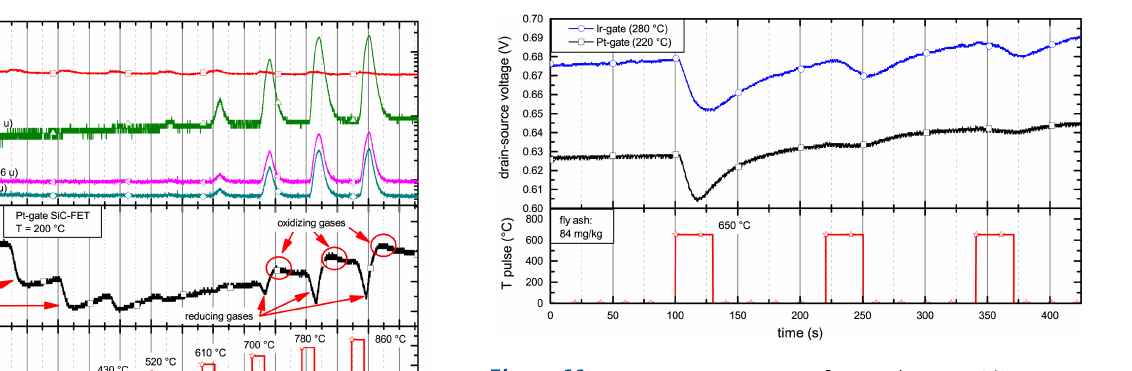
Figure 11. Top: sensor responses of Pt- and Ir-gate SiC-FETs at 220 and 280 ◦ C, respectively. Bottom: heating pulses up to 650 ◦ C.